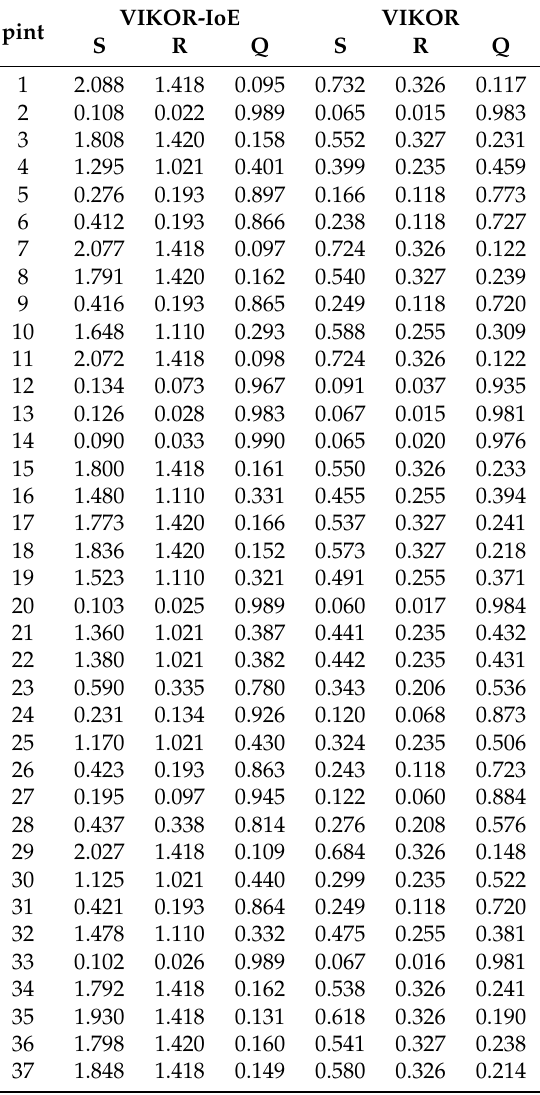
Table 4. Values of the VIKOR and IoE-VIKOR models in each random